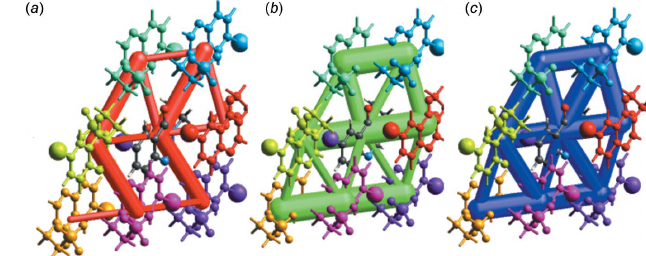
Figure 6 Intermolecular energy frameworks of ( a ) E ele , ( b ) E dis and ( c ) E tot in the structure of (I), viewed down the b